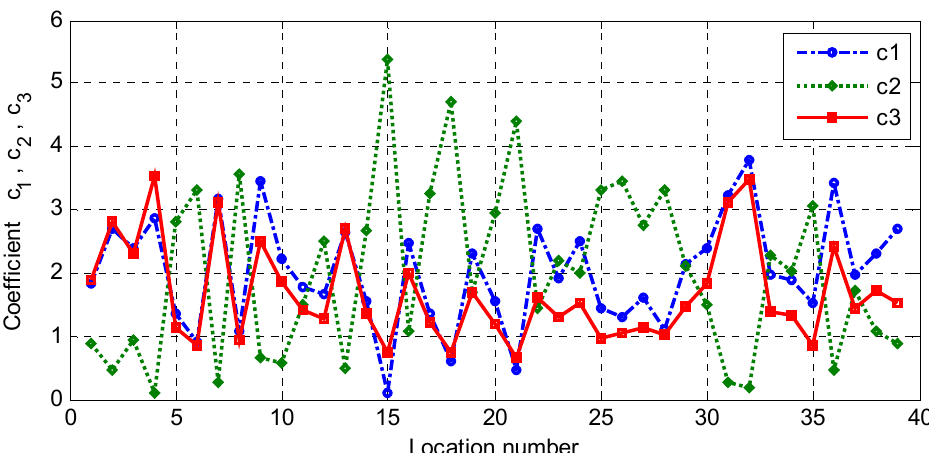
Figure 13. Model parameters c1 – c3 for description of the joint distribution of u w and Hs per location.